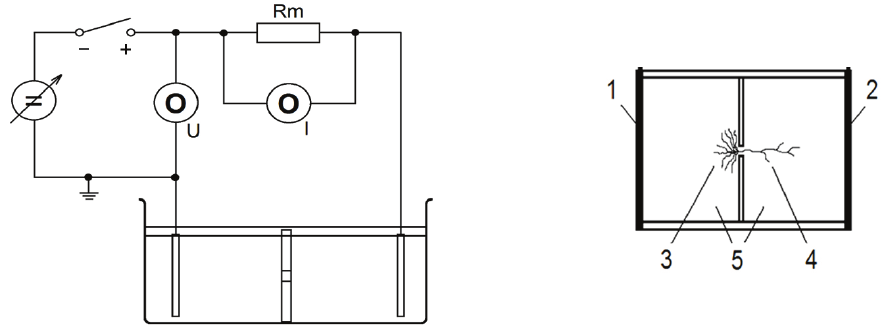
Figure 1 : Left: Schematic configuration of the experimental reactor. Right: Formation of plasma streamers in the pin-hole during DC discharge. 1 – anode, 2 – cathode, 3 – negative streamer, 4 – positive streamer, 5 – electrolyte solution.